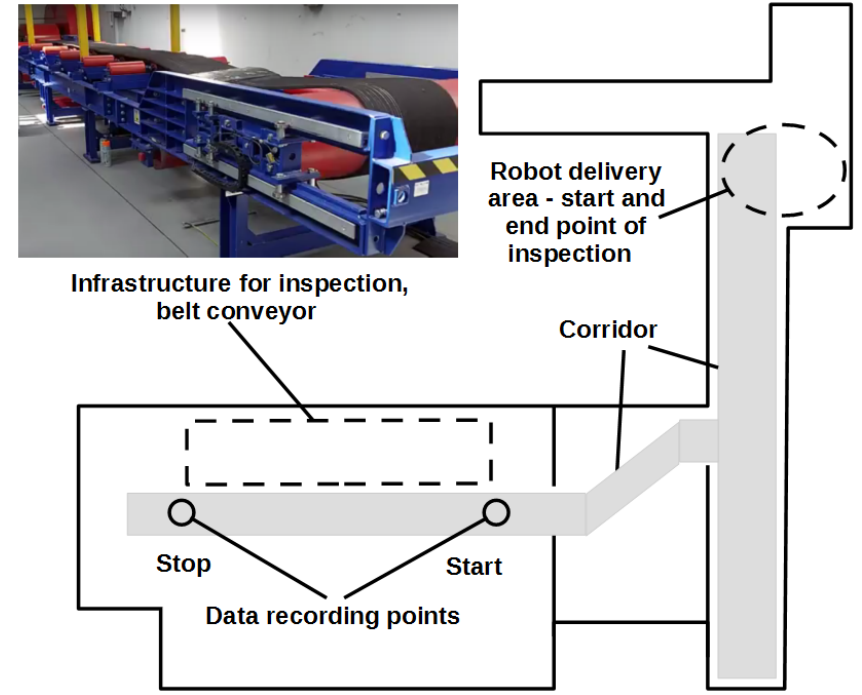
Figure 4. Inspection area layout.